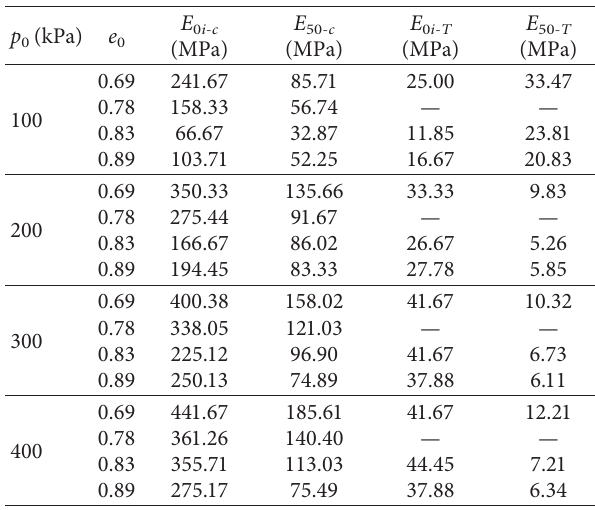
Table 6: Initial elastic modulus and secant modulus at 50% of the peak strength of moral mud and Taizhou soil.